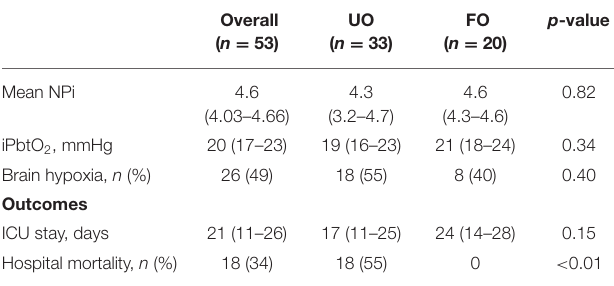
TABLE 1 | Characteristics of study population, according to neurological outcome (UO, unfavorable; FO,